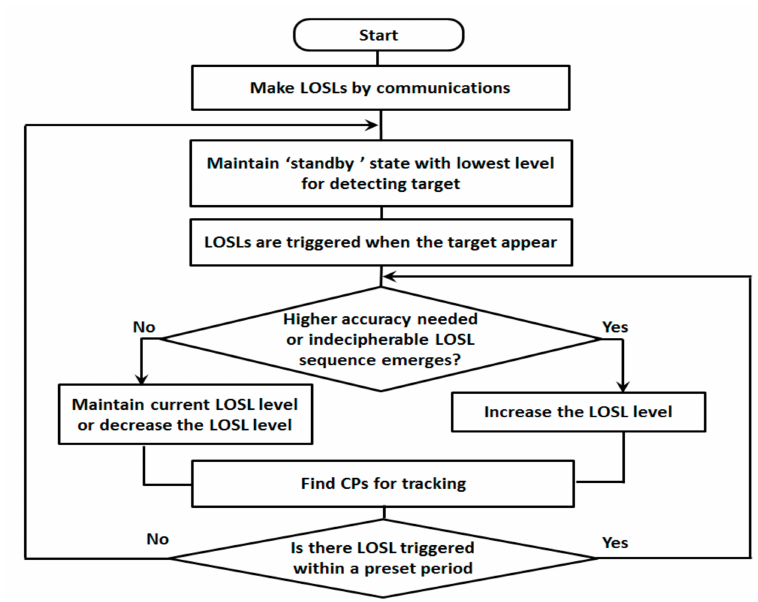
Figure 8. Flow chart of proposed adaptive networking scheme for tracking device-free targets.